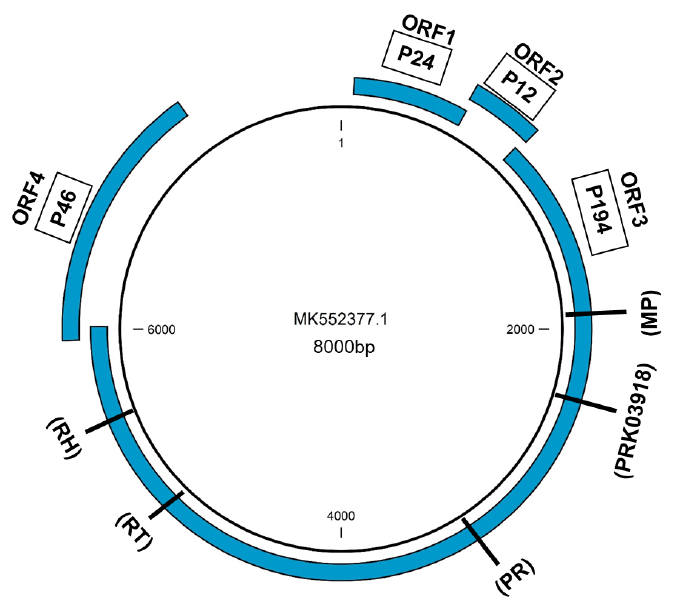
Figure 1. Genomic organization of RTBV-SP (RTBV: accession no. MK552377.1). The open reading frames are shown in blue (ORF 1, ORF 2, ORF 3, and ORF 4).